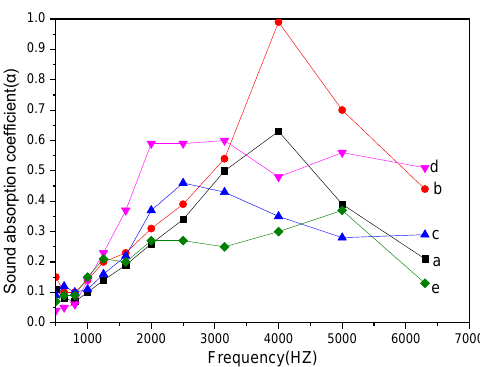
Figure 7. Effect of 2 mm PVA/PEO membranes sound absorption properties. ( a ) 8 wt % PVA; ( b ) 8 wt % PVA/3 wt % PEO (90/10); ( c ) 8 wt % PVA/3 wt % PEO (80/20); ( d ) 8 wt % PVA/3 wt % PEO (70/30); ( e ) 3 wt % PEO.